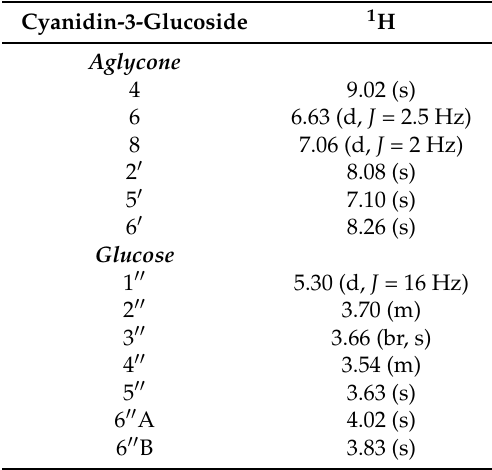
Table 2. 1 H spectral data (ppm) for purified C3G.